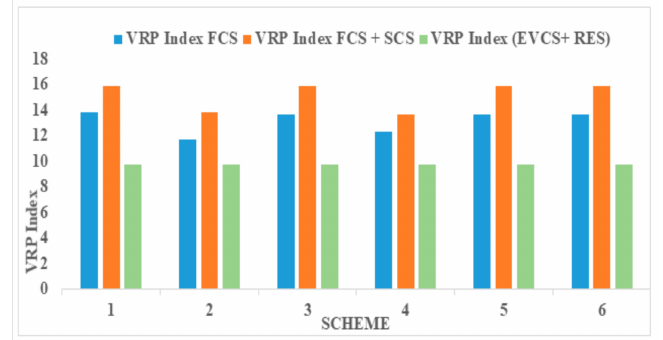
Figure 10. VRP index of the modified IEEE 33-bus system.